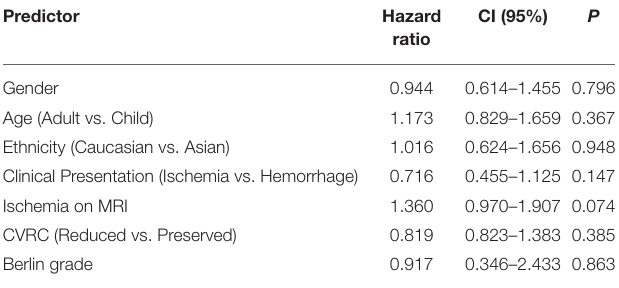
TABLE 5 | Model summary of univariate Cox regression